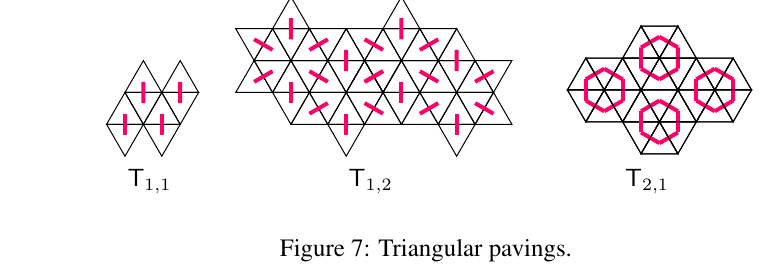
Figure 7: Triangular